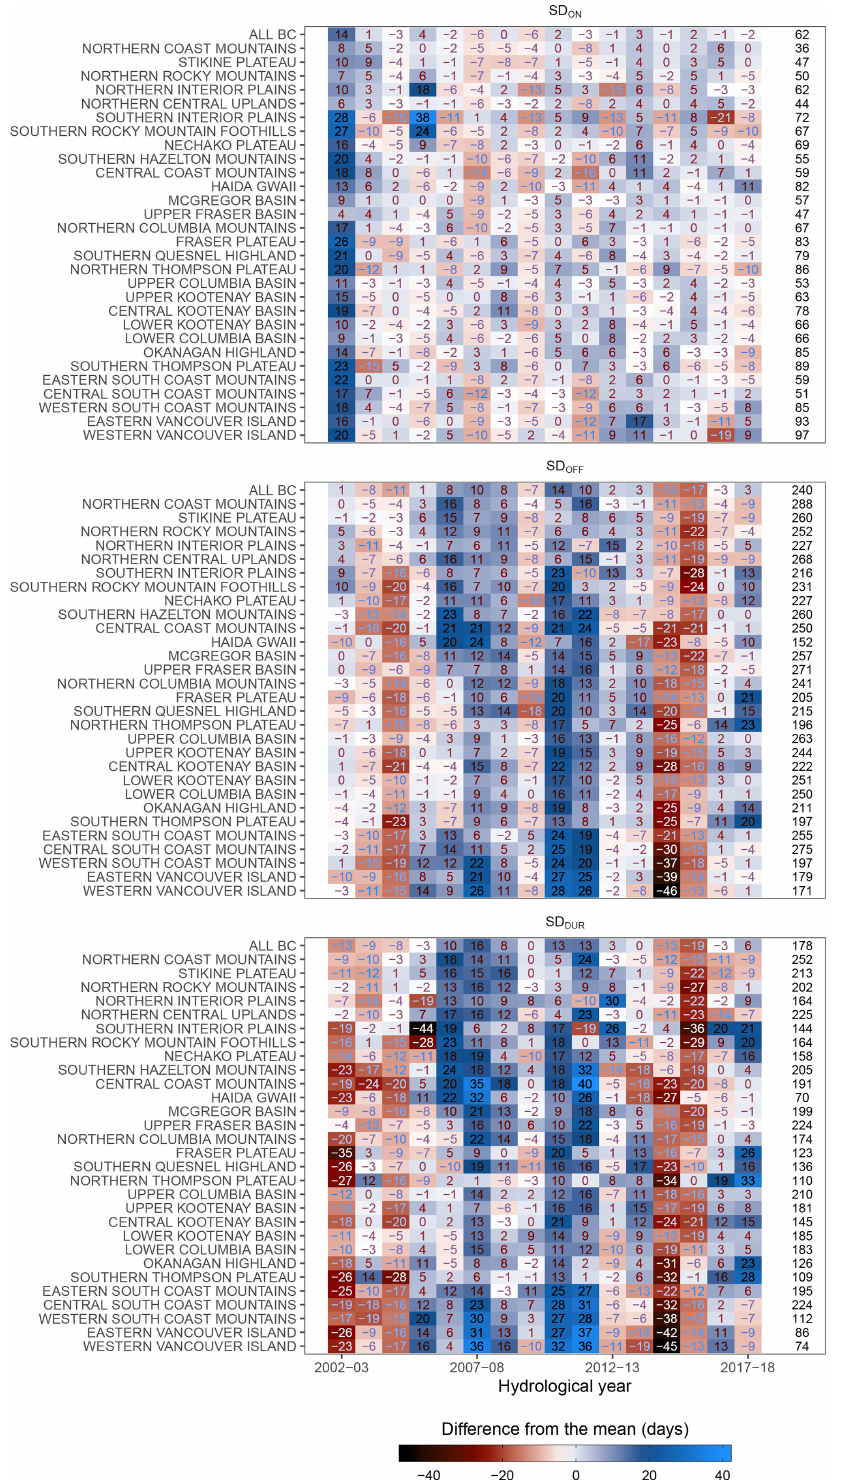
Figure 7. Difference from the mean of SD ON , SD OFF , and SD DUR (in days) for each hydrozone and for all BC over time. Mean zonal values (in days after 1 September for SD ON and SD OFF ; in days for SD DUR ) are found at the right-hand side of each plot. The x axis is in hydrological years starting on 1 September for each year; for example, the label 2002–2003 represents 1 September 2002–1 September 2003.